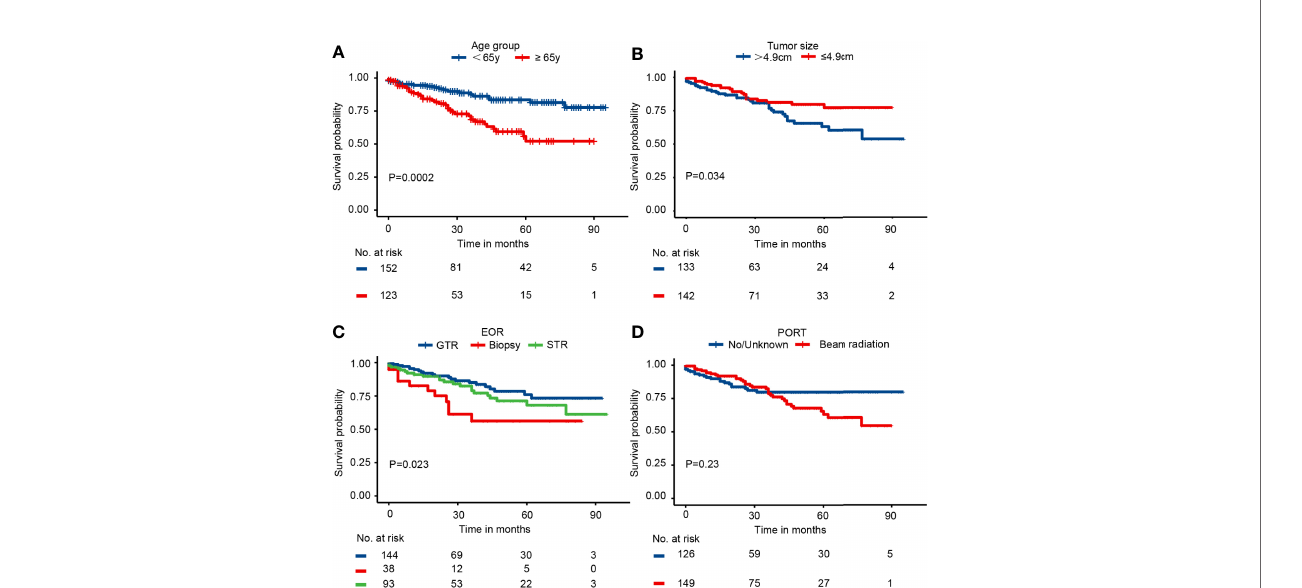
FIGURE 2 | The Kaplan – Meier curves by (A) age group, (B) tumor size, (C) EOR, and (D) PORT in the entire